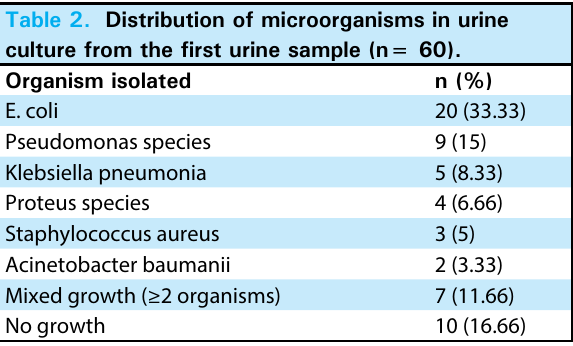
Table 2. Distribution of microorganisms in urine culture from the first urine sample (n= 60). Organism